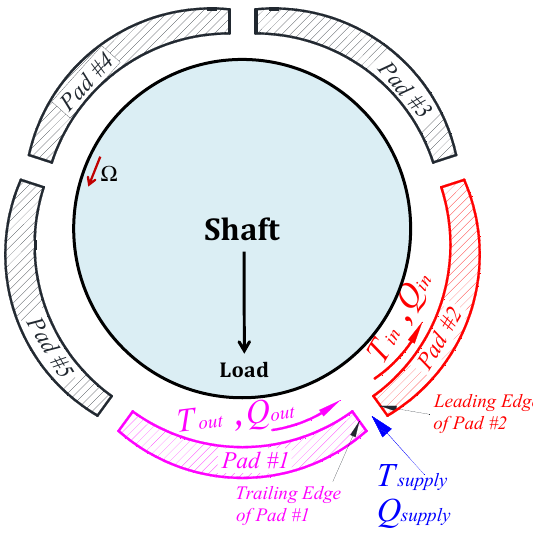
Figure 2. TPJB structure and oil supply plant.